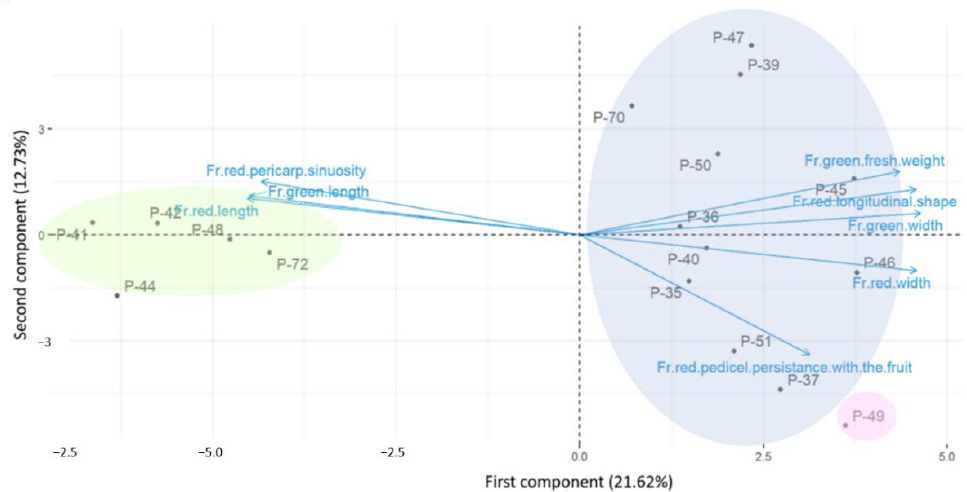
Figure 8. Similarities among the pepper fruits belonging to the 17 evaluated pepper landraces based on the traits used for phenotyping represented in the two first components (first component, x -axis; second component, y -axis) of the principal components analysis (21.62% and 12.73% of total variation, respectively). Groups, arranged mainly according to fruit morphology (G1 = thin and elongated, G2 = thick and robust), are represented and rounded in plots G1 (green) and G2 (blue). Ungrouped P-49 (pink) is also expressed in the figure. Light blue arrows represent the eight strongest traits that contribute the most to total diversity among landraces, extracted from a previous feature plot performed with all the traits in the assay (data not